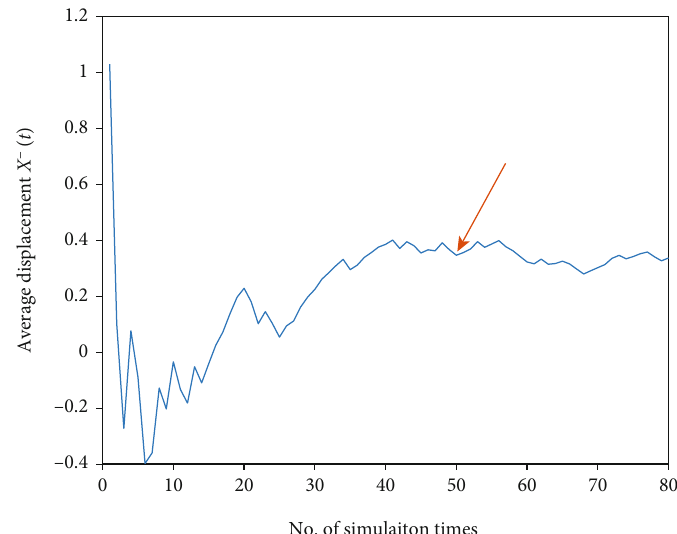
No. of simulaiton times Figure 2: The relationship between the average displacement and the number of simulation time at a certain time. x -axis is the number of simulation time; y -axis is the average